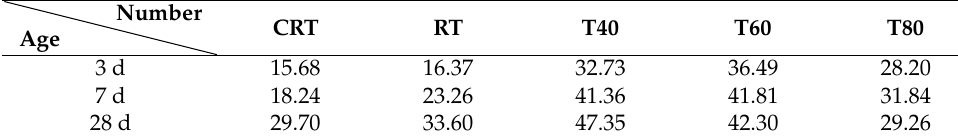
Figure 9. Compressive strength of mortars cured for 3, 7, and 28 days.